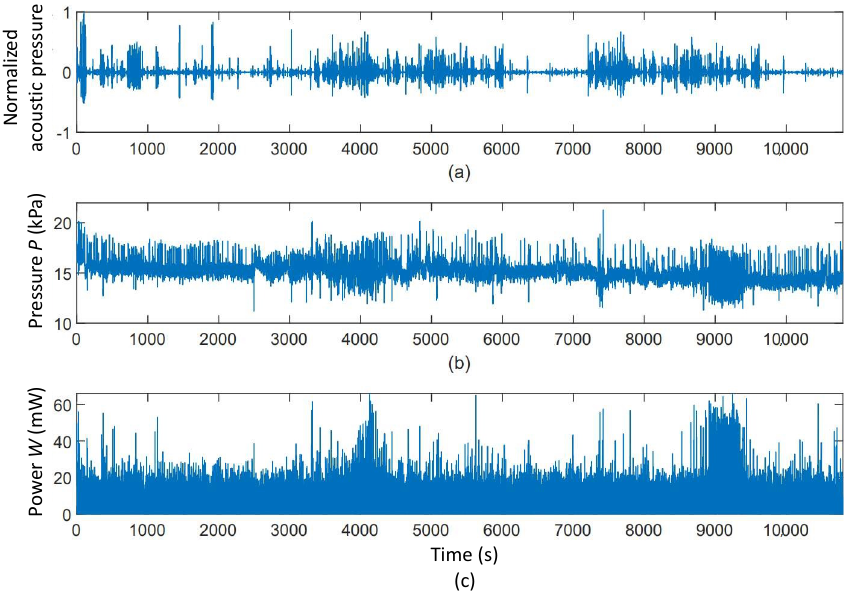
Figure 5. Audio, pressure and instantaneous power signals. ( a ) Audio, ( b ) Pressure and ( c ) Instantaneous power